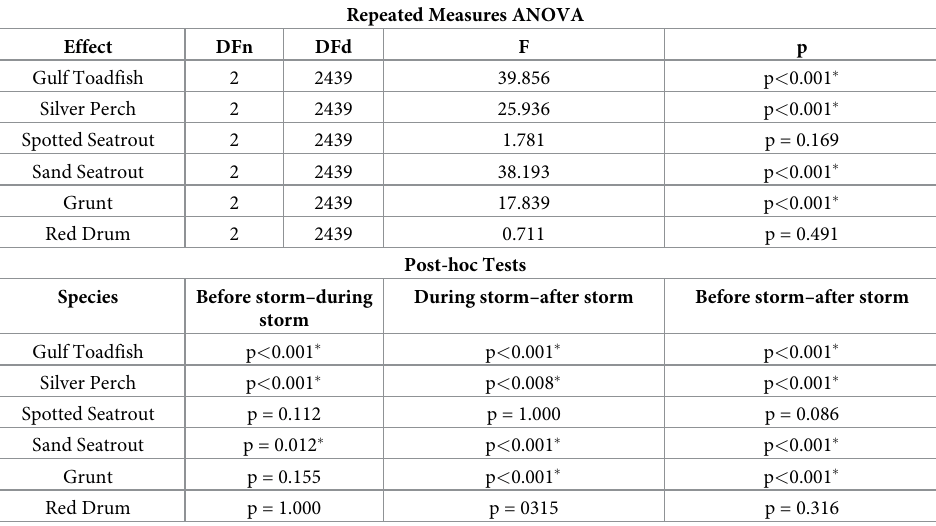
Repeated measures ANOVA and Tukey post-hoc test results comparing fish species detections per file before, during and after Tropical Storm Debby at station Boca 3. � Indicates significant results (p <